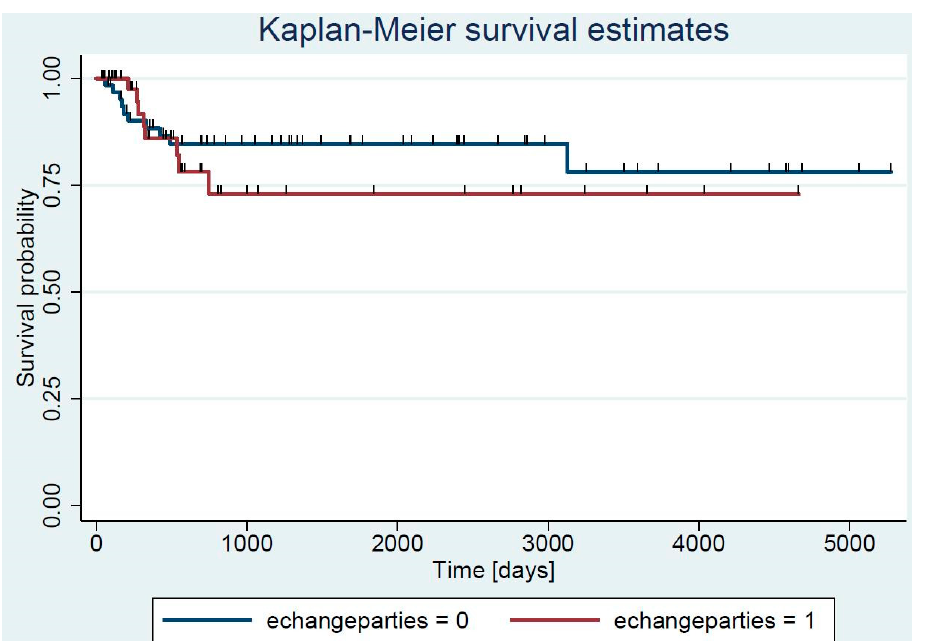
Figure 2. Kaplan–Meier curve stratified upon the exchange of mobile parts. Echangeparties = exchange of mobile parts. Of note, the benefit of exchange is only visible during the first year (first 400 days). Thereafter, the curves remain parallel. The corresponding hazard ratios and 95% confidence of the exchange are 1.9; 1.2–2.9; and, for non-exchange 0.5, 0.8–1.0,